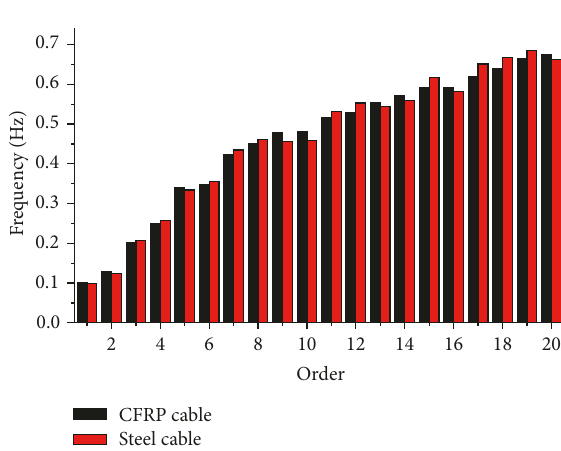
Figure 11: First 20-order frequencies of two cable-stayed bridges.